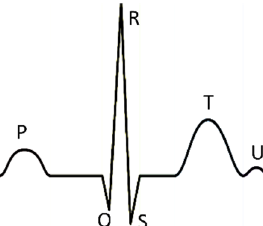
Figure 1. There is a normal heartbeat in electrocardiogram (ECG). The atria’s depolarization caused the P wave; the ventricles’ depolarization caused the QRS complex; the repolarization of the ventricles caused the T wave; the repolarization of the Purkinje fibers caused the U wave.